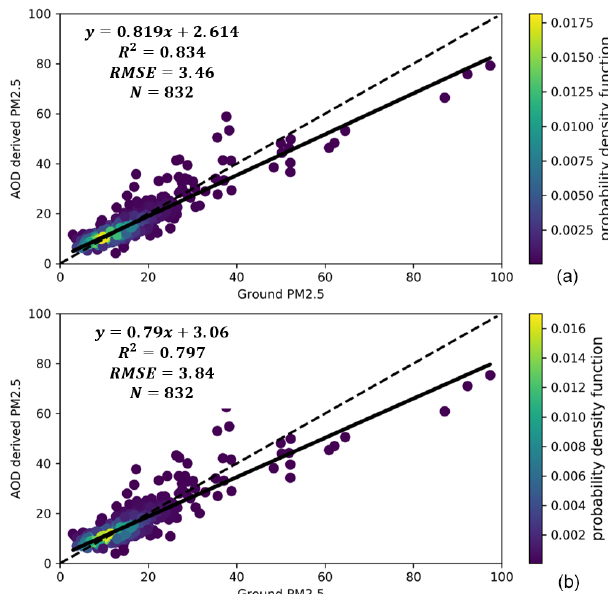
Figure 3. Results of model fitting and cross-validation for the GWR model for the entire US region averaged from 9 to 25 August 2018. (a) GWR model fitting results; (b) GWR model LOOCV results. The dashed line is the 1:1 line as a reference and the black line shows the regression line. The color of the scatter plots represents the probability density function which provides a relative likelihood that the value of the random variable would equal a certain sample.